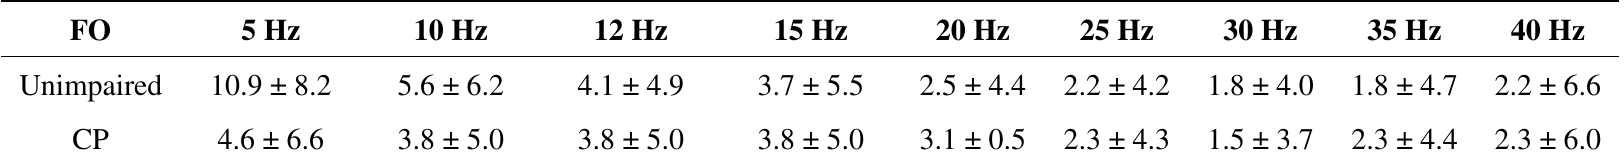
Table 2. Absolute mean difference ± one standard deviation (ms) in detection of the Foot Off (FO) using raw data and data low pass filtered from an unimpaired subject and one subject with CP. The cut off frequencies used were 5, 10, 12, 15, 20, 25, 30, 35 and 40 Hz. n = 32 FO events for unimpaired subject and 13 for subject with